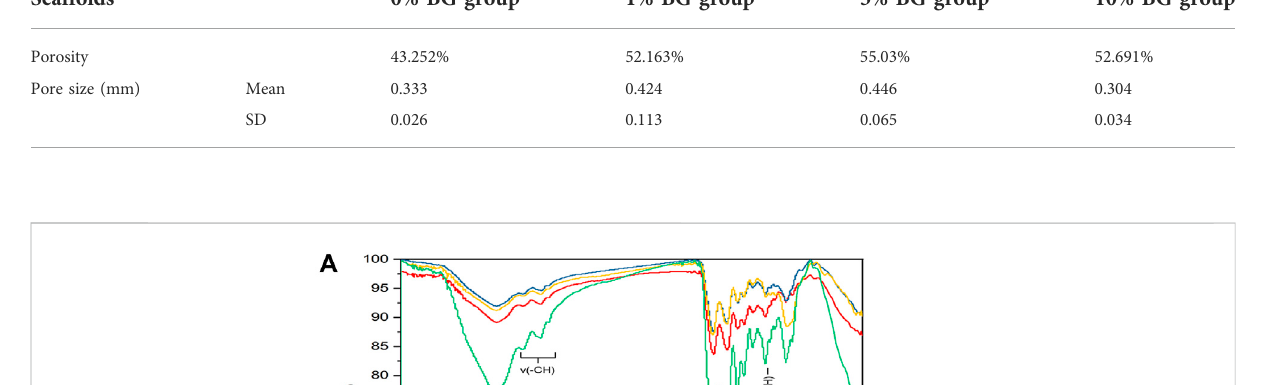
TABLE 3 Porosity and pore size analysis of 3D-printed BG/GelMA scaffolds. Scaffolds Porosity